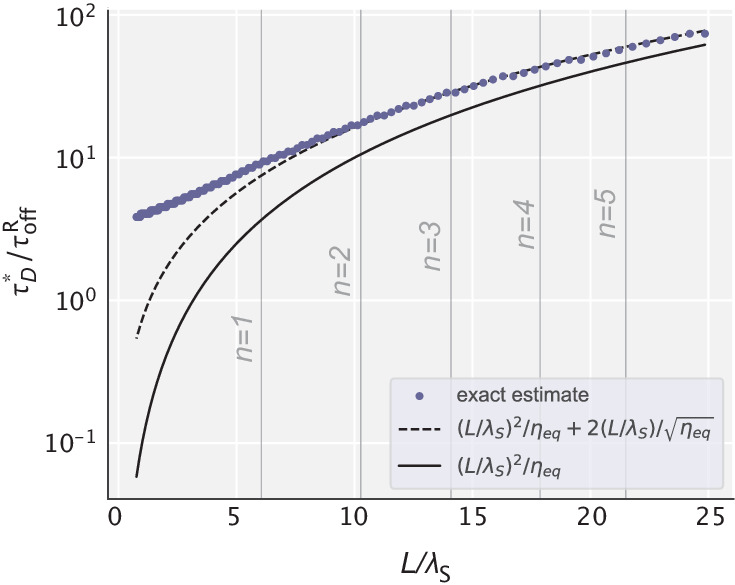
Optimal diffusion time scale for different choices of λS.Blue dots represent the exact values obtained numerically for the data in Figure 3c. Dashed and solid lines represent the analytical estimates with and without the correction term. Vertical lines correspond to those values of L/λS that yield an integer number of effective proofreading realizations.